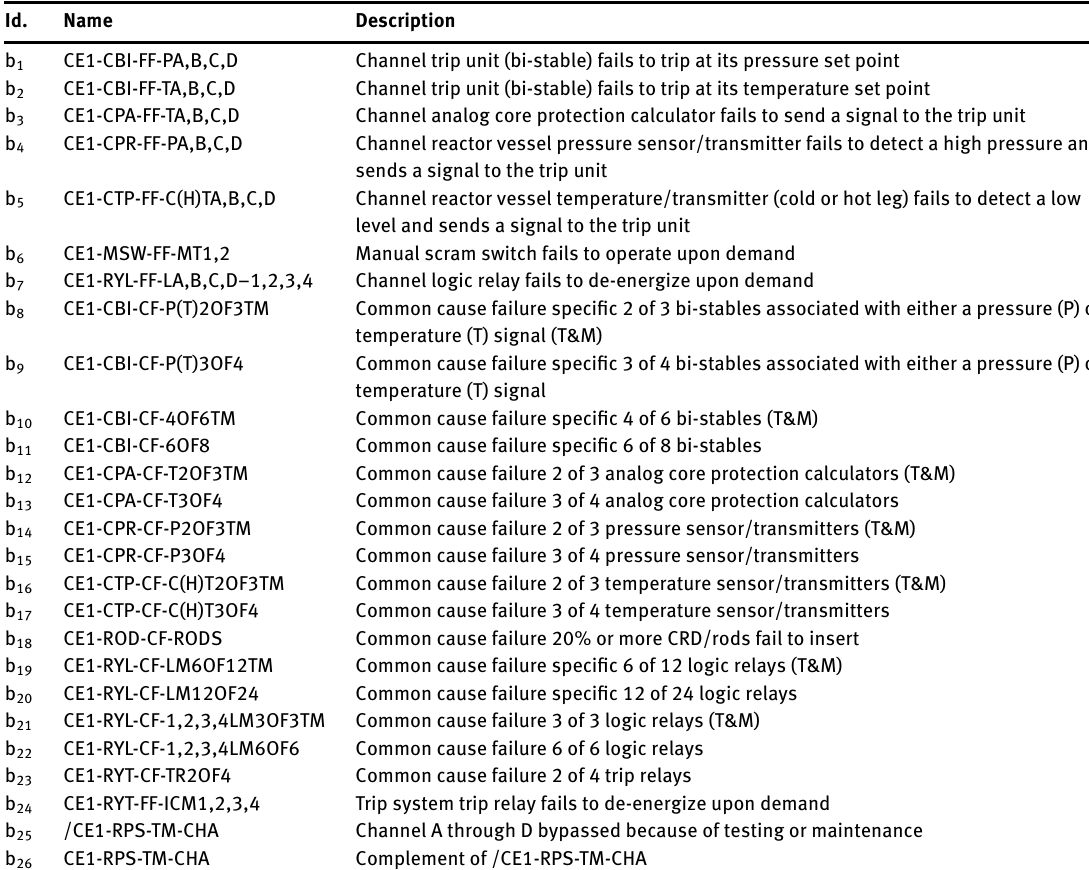
Table 1: Basic Events of the U.S. CERPS Fault Tree [47].